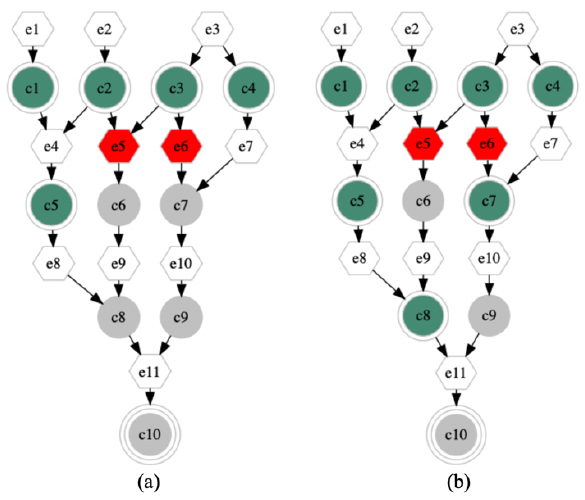
Figure 3. Sample evolution (real network) of the security state for a given state-action-type (𝑠 the security state 𝑠 defense action 𝑢 blocked exploits are shown with red shaped